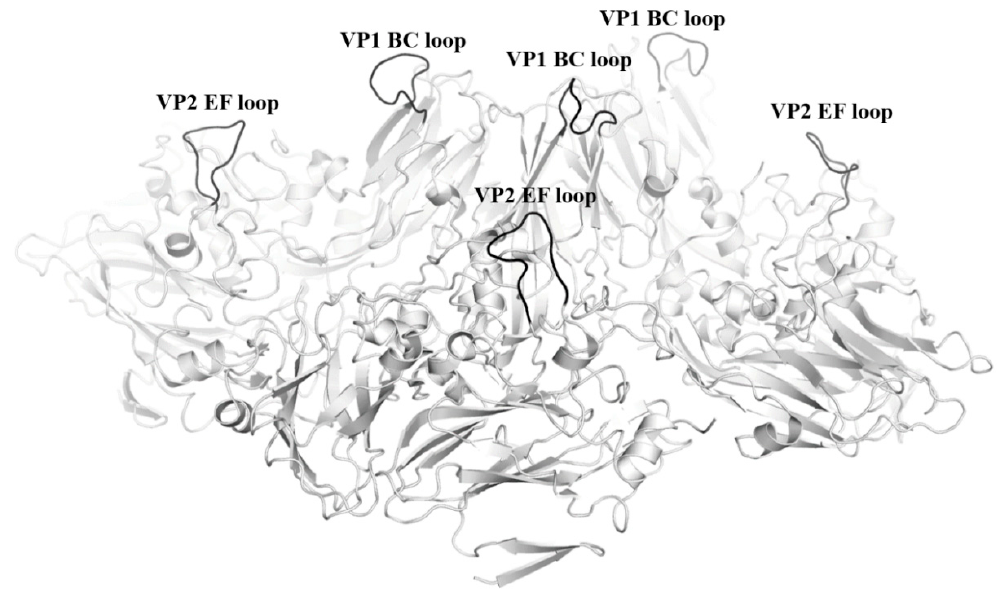
Figure 1. Position of VP1 BC loop and VP2 EF loop on the EV-A71 viral capsid. Representation of the EV-A71 VLP viral capsid. VP1, VP2 and VP3 structural proteins are shown in grey. The VP1 BC loop and VP2 EF loop are shown in black and labelled. PDB code: